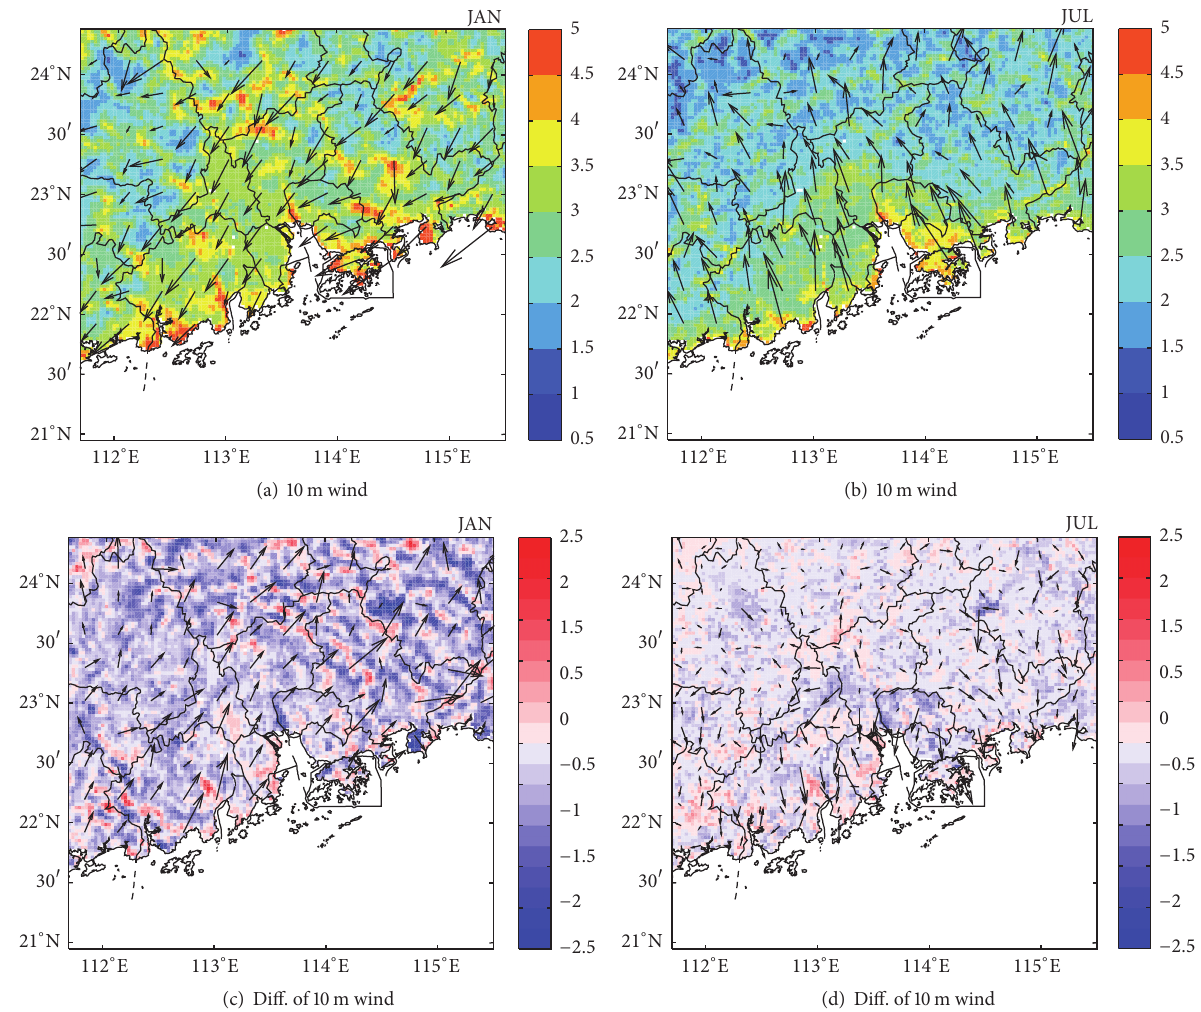
Figure 5: The simulated spatial distribution of monthly-average 10m wind in the GLC2009 case (a, b) and spatial distribution of monthly- average 10m wind differences between the GLC2009 case and the GLC2000 case (c, d) (differences = GLC2009 −